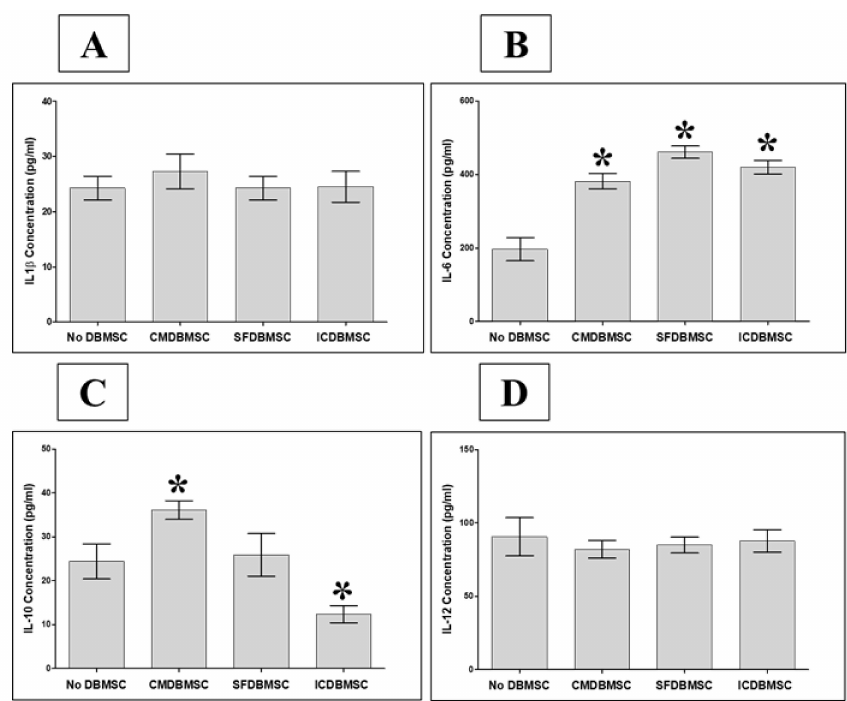
Figure 7. Effects of DBMSCs on GM-CSF–stimulated human monocyte-to-macrophage differentiation, as analyzed by the secretion of IL-1 β , IL-6, IL-10, and IL-12 using sandwich ELISA. CMDBMSCs had no significant effect ( p > 0.05) on the secretion profiles of IL-1 β ( A ), significantly increased (* p < 0.05) the secretion profiles of IL-6 ( B ) and IL-10 ( C ), and had no significant effect ( p > 0.05) on the secretion profiles of IL-12 ( D ) of macrophages. In addition, SFDBMSCs had no significant effect ( p > 0.05) on